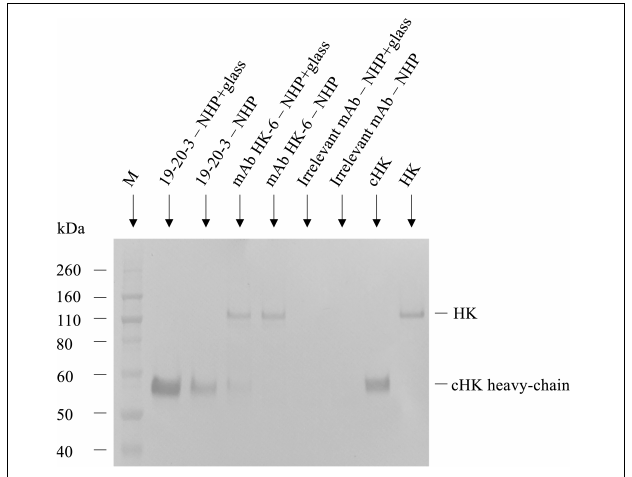
FIGURE 3 | Reactivity of cleaved H-kininogen (cHK) specific monoclonal antibodies (mAbs) by immunoprecipitation. The reactivity of cHK specific mAb 19-20-3 and native HK mAb 19-31-6 were analyzed by immunoprecipitation followed by SDS-PAGE and western blotting. cHK and HK were immunoprecipitated by the mAbs from glass activated normal human plasma (NHP + glass) and normal human plasma (NHP). The samples were subjected to SDS-PAGE and western blotting, followed by development with biotinylated polyclonal rabbit anti-HK. Lane M indicate the molecular weight marker.